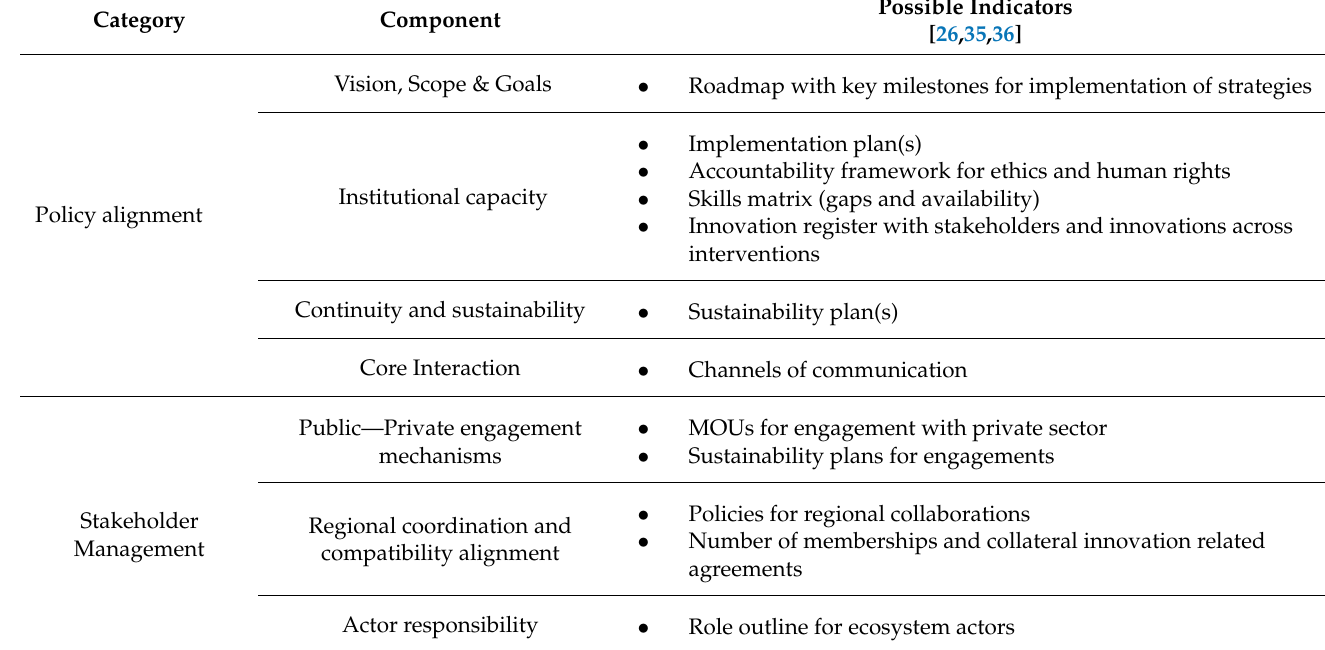
Table 3. Framework